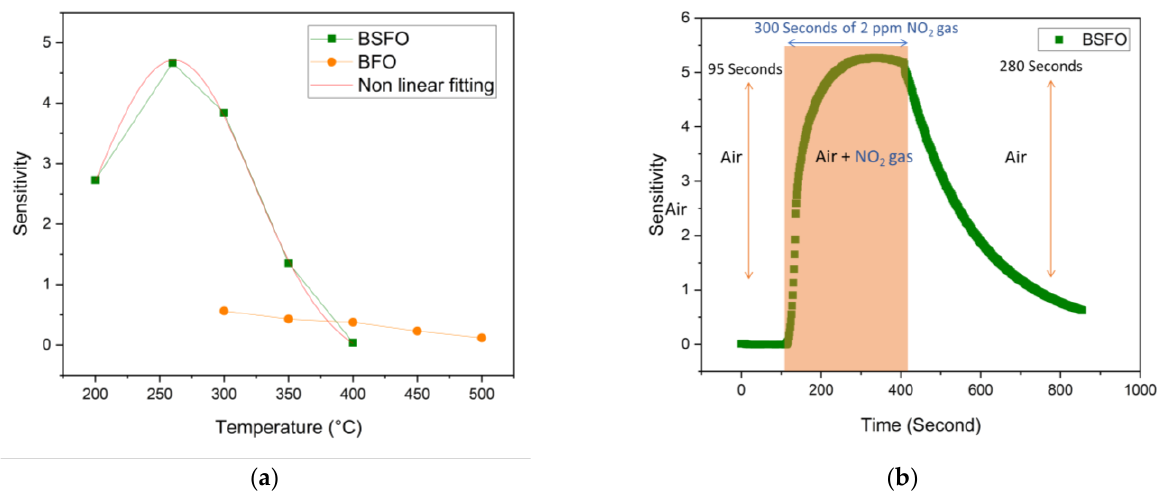
Figure 6. ( a ) Sensitivity chart of BSFO and BFO. ( b ) Response curve of BSFO at 260